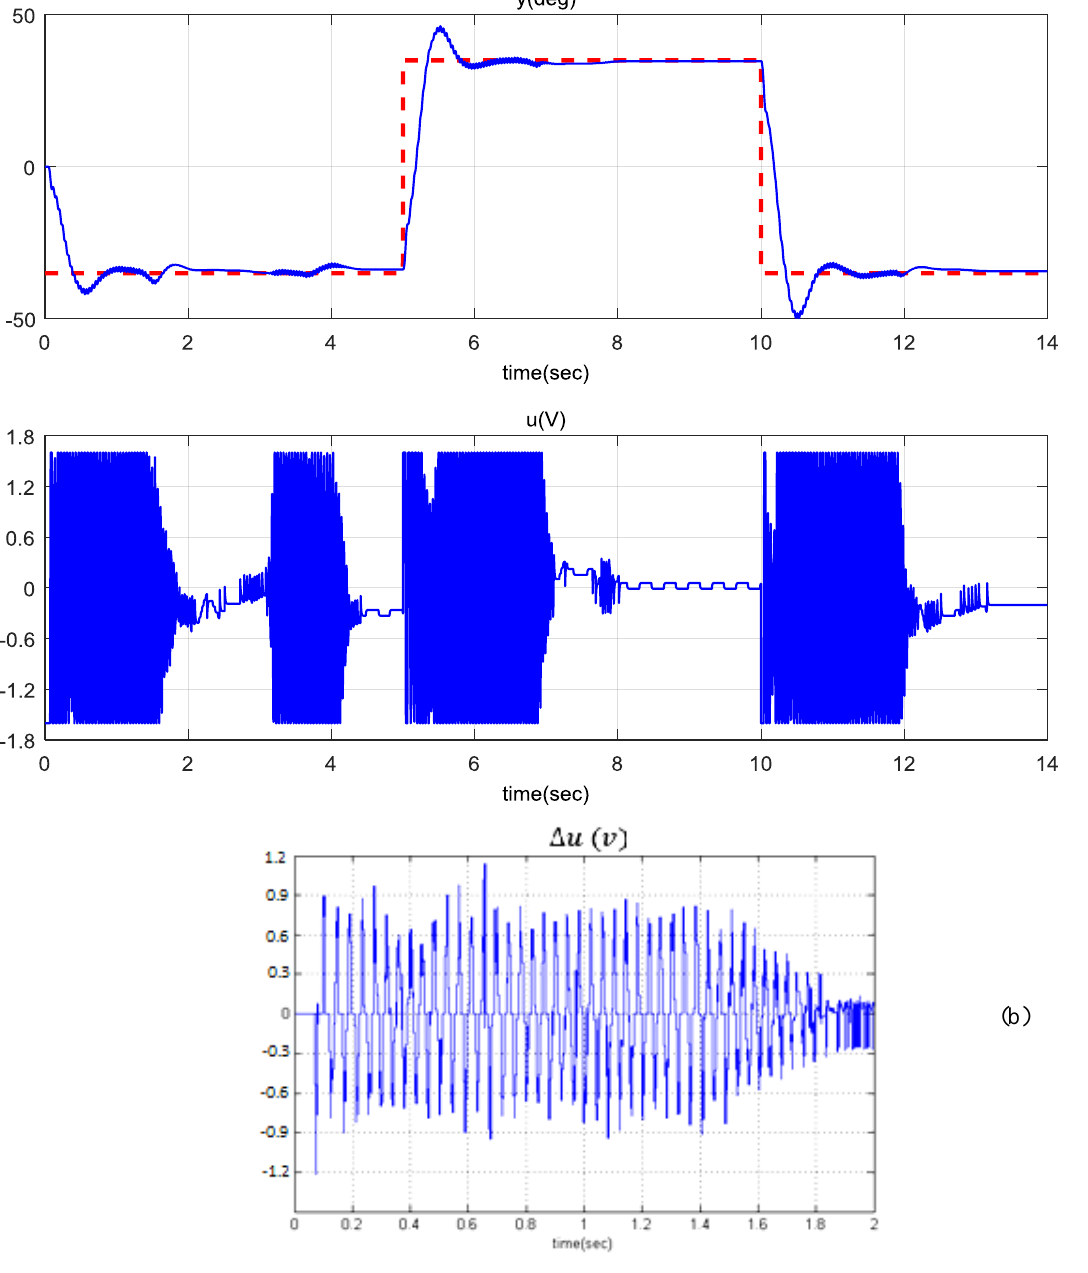
Figure 2. (a) input signal at its peak value, and (b) its rate